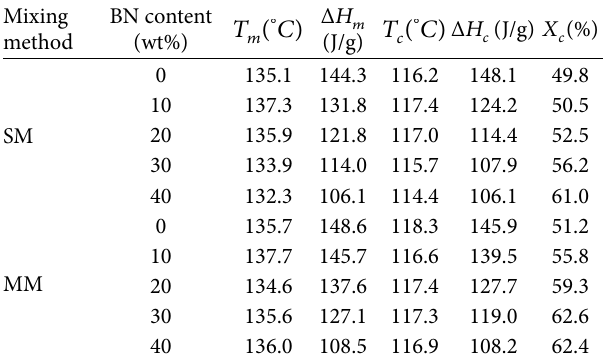
Figure 4: Heating melting function curve of UHMWPE composites by solvent mixing (a) and melt mixing (b), respectively. Table 1: DSC thermal parameters of UHMWPE/BN composites by solvent mixing and melt